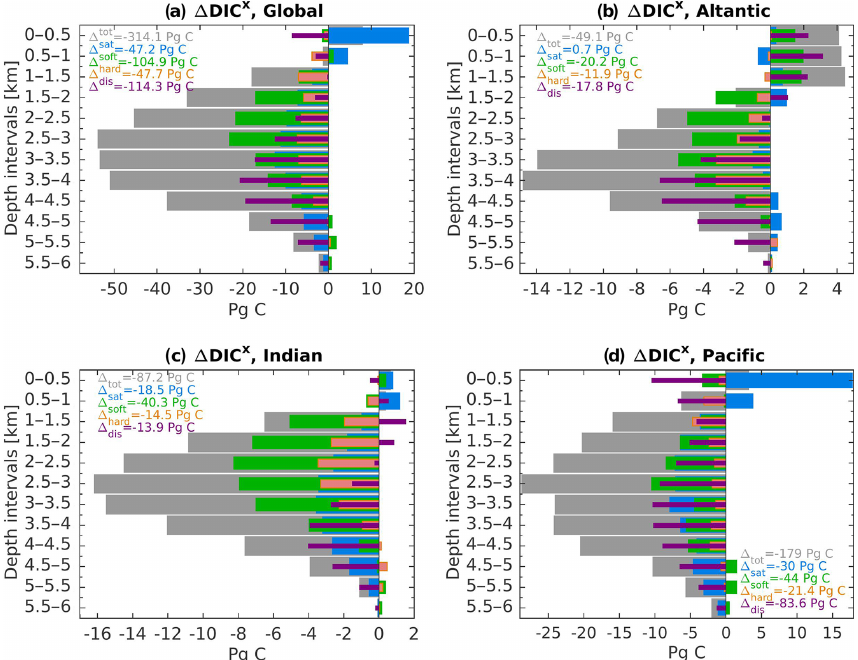
Figure 6. DIC differences between 125 and 115ka ( (cid:49) DIC x ) in (a) the global ocean and the (b) Atlantic, (c) Indian, and (d) Pacific basins. The (cid:49) DIC x is averaged over a 500m depth interval where “ x ” refers to the different components of the DIC. The DIC tot is represented by the gray bars and is decomposed into its four components: (cid:49) DIC sat (blue), (cid:49) DIC soft (green), (cid:49) DIC carb (orange), and (cid:49) DIC dis (purple). The sum throughout the water column of each components is given by the